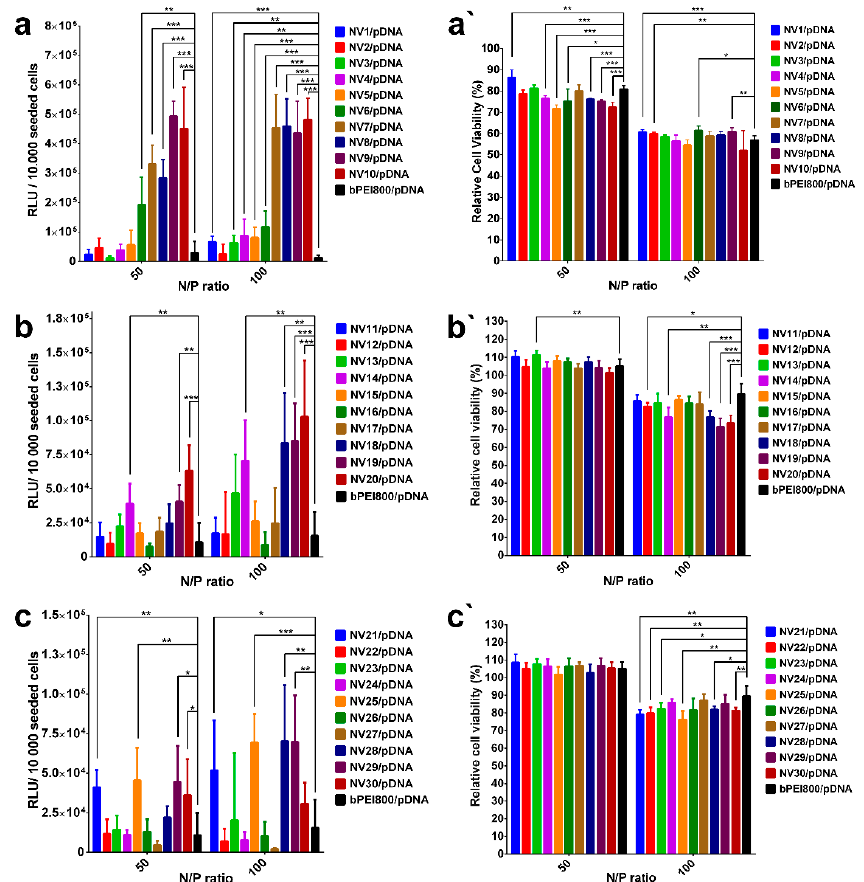
Figure 6. In vitro transfection e ffi ciency of NV1-NV30 on HeLa cells (results given in relative light units (RLU) per 10000 cells): ( a ) Polyplexes containing PEG 1500 Da, ( b ) polyplexes containing PEG 2000 Da, ( c ) polyplexes containing PEG 3000 Da. In vitro MTS cytotoxicity tests on HeLa cells: ( a (cid:48) ) Polyplexes containing PEG 1500 Da, ( b (cid:48) ) polyplexes containing PEG 2000 Da, ( c (cid:48) ) polyplexes containing PEG 3000 Da. The results are presented as a mean value ± the standard deviation (S.D.); n = 6–8. * p < 0.05, ** p < 0.01, and *** p < 0.001 by Student’s